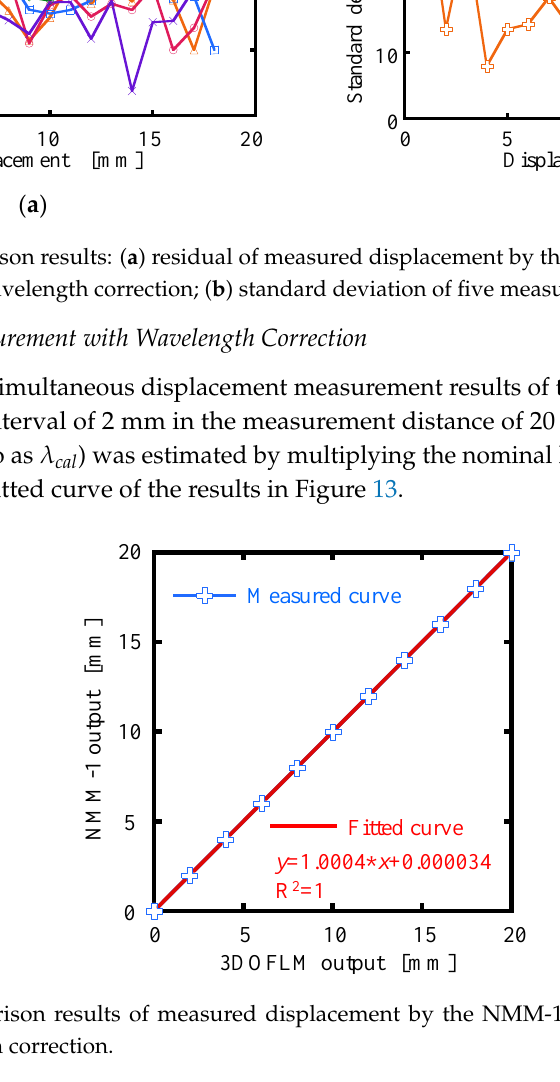
Figure 14. Stability of output signals of the autocollimator (AC2) in the wavelength corrector kit. The angular measurement accuracy of AC2 was calibrated by the HP5529A system and the results are shown in Figure 15. It can be seen that the angle residual for the range of ±100 arcsec was within ±0.5 arcsec. It is verified that AC2 was acceptable for sub-arcsecond precision angular error measurement.